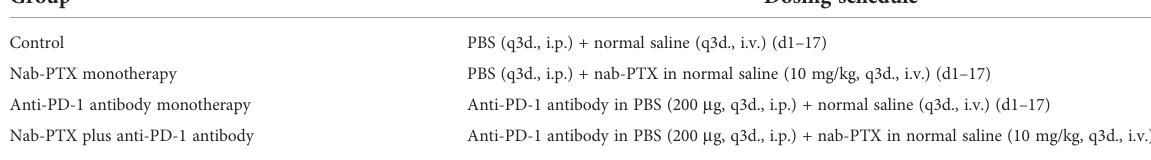
TABLE 1 Experimental groups and dosing schedules of mouse LLC models ( n = 6).